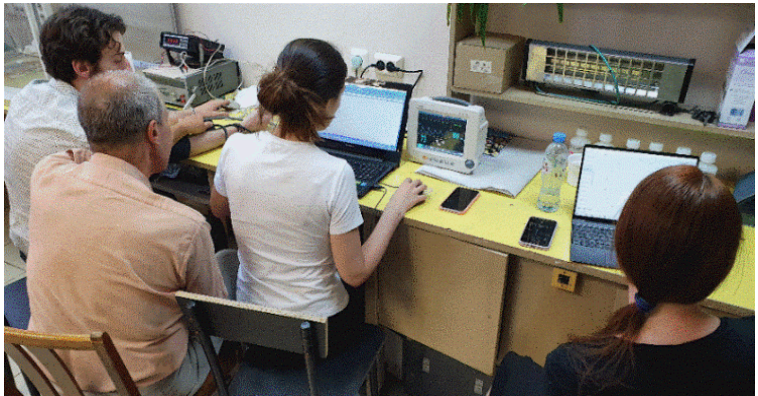
Figure 7. Testing patients.